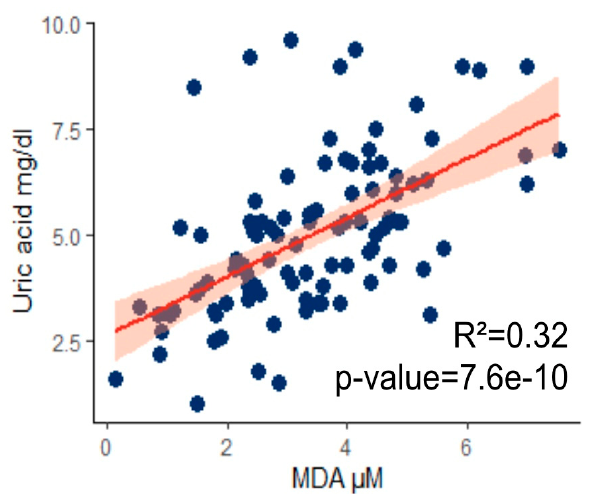
Figure 4. Uric acid in plasma of sarcopenic elderly correlates with malondialdehyde (MDA) content. Data correlated except for outlier values.